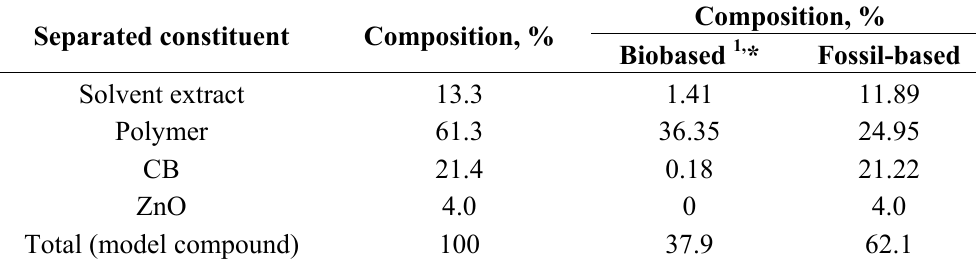
Table 11. Calculated biobased and fossil-based masses for separated